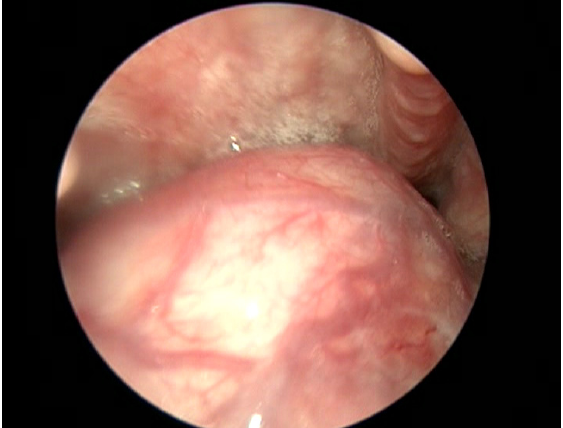
Figure 1. 70 degrees rigid hypopharyngoscope shows the mass in the sublingual region.